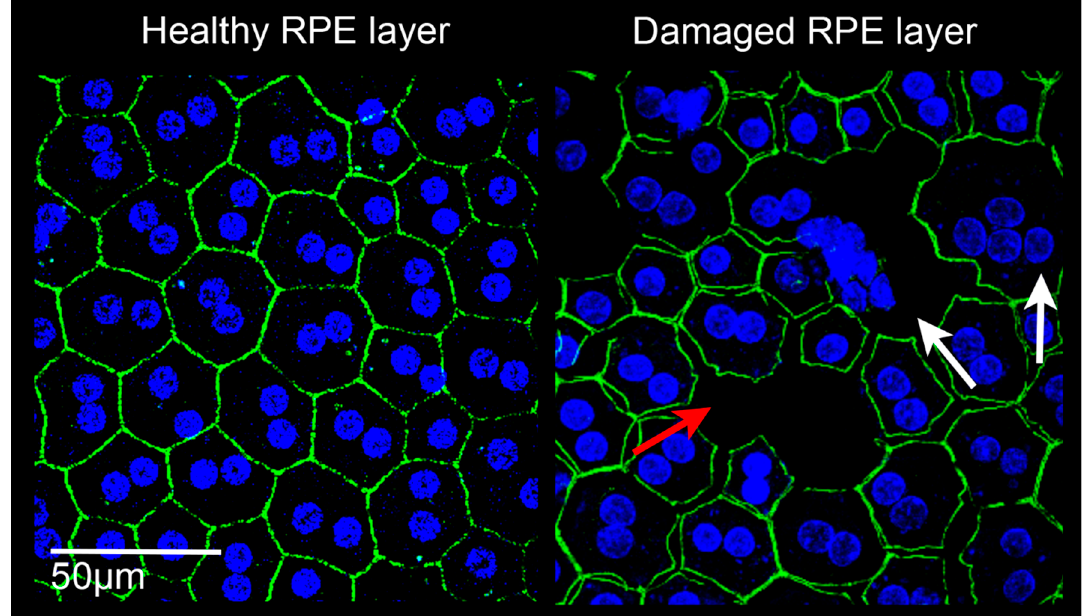
Figure 3. Confocal images of retinal pigment epithelium (RPE) in rats. Left: RPE from a healthy albino Sprague Dawley rat. The RPE is constituted by a homogeneous monolayer of joined epithelial cells displaying a hexagonal morphology. Right: RPE from a light damaged albino Sprague Dawley rat. The RPE structure appears clearly altered, cell junctions are lacking (red arrow), the onset of multinucleation suggests epithelial-mesenchymal transition (white arrows), and some cells have degenerated. Images were acquired by Leica TCS SP5 confocal microscope; 60X magnification. Green: phalloidin staining; blue: bisbenzimide nuclear dye; scale bar: 50 μ m.